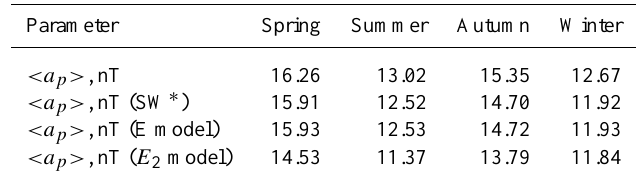
Table 1. Averaged a p index and its solar wind